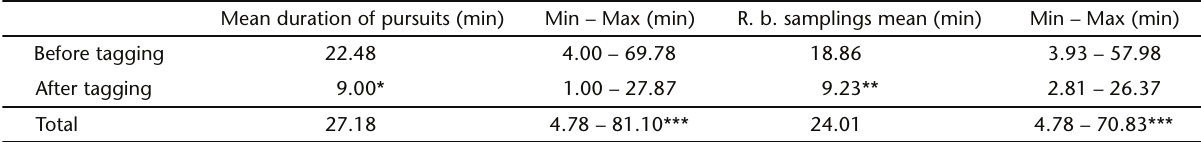
Table I. Mean duration of pursuit and respiratory behavior (r.b.). Total and partial duration mean, before and after tagging.